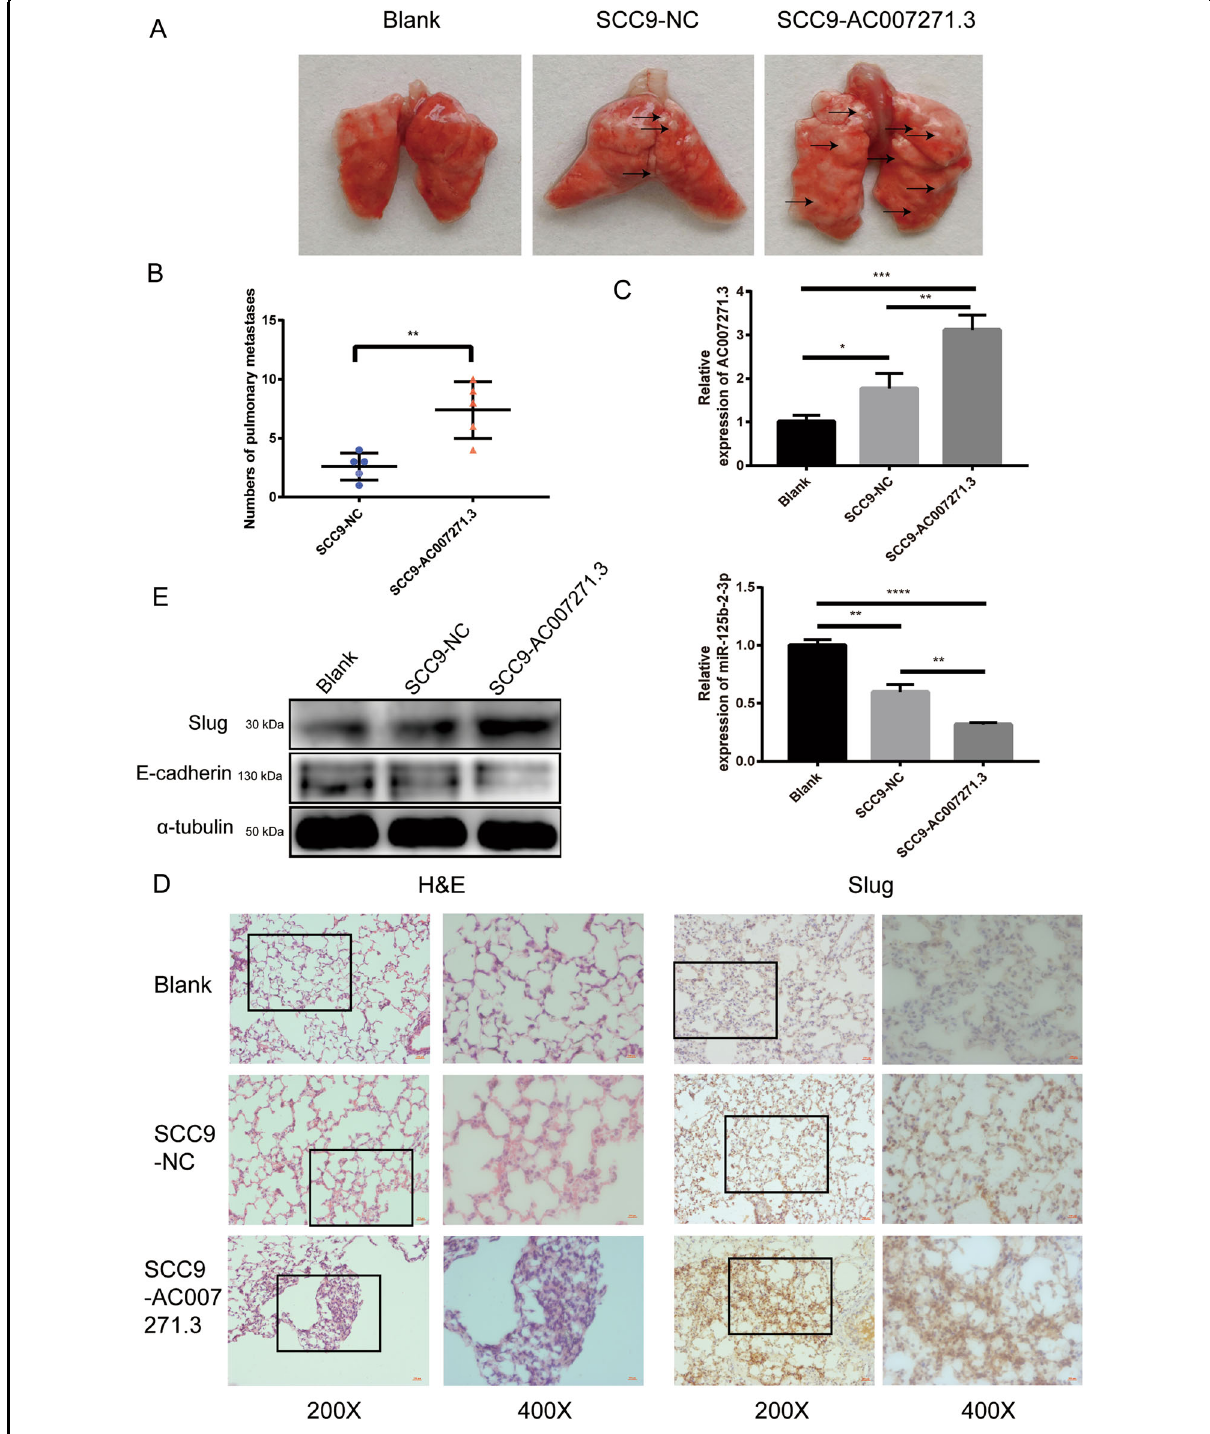
Fig. 6 AC007271.3 promoted OSCC metastasis in vivo. a Representative images of pulmonary metastatic models. b Statistical analysis of colony numbers of pulmonary metastases between SCC9-AC007271.3 and SCC9-NC group ( n = 5). c The expression of AC007271.3 and miR-125b-2-3p in pulmonary metastases were detected by qRT-PCR. d Representative images of HE and IHC staining. Higher level of Slug was detected in SCC9- AC007271.3 group than that in SCC9-NC group. e Western blot con fi rmed the upregulation of Slug and the downregulation of E-cadherin in SCC9- AC007271.3 group. * p < 0.05, ** p < 0.01, *** p < 0.001, **** p <